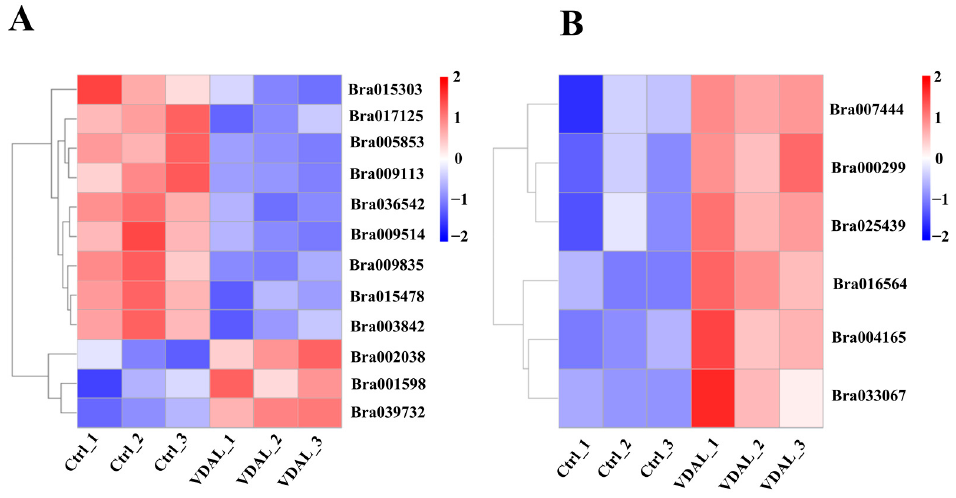
Figure 8. Heat map of hierarchical clustering of genes expressed in B. rapa inoculated with S. sclerotiorum after spraying with water or VDAL. ( A ) The heat map of genes associated with MAPK and plant hormone signal transduction. Bra015303, ethylene response sensor 2 (ERS2); Bra017125, abscisic acid (ABA) receptor PYL4; Bra005853, ABA receptor PYL5; Bra009113, ABA receptor PYL5; Bra036542, EIN3-binding F-box protein 2, Bra009514; serine/threonine-protein ki- nase CTR1; Bra009835, EIN3-binding F-box protein 2; Bra015478, ethylene-responsive transcription factor ERF094; Bra003842, mitogen-activated protein kinase kinase (MAPKK) 9; Bra002038, protein phosphatase 2C 37; Bra039732, auxin-responsive protein IAA1; and Bra001598, auxin-responsive protein IAA19. ( B ) The heat map of genes associated with plant–pathogen interaction. Bra007444,